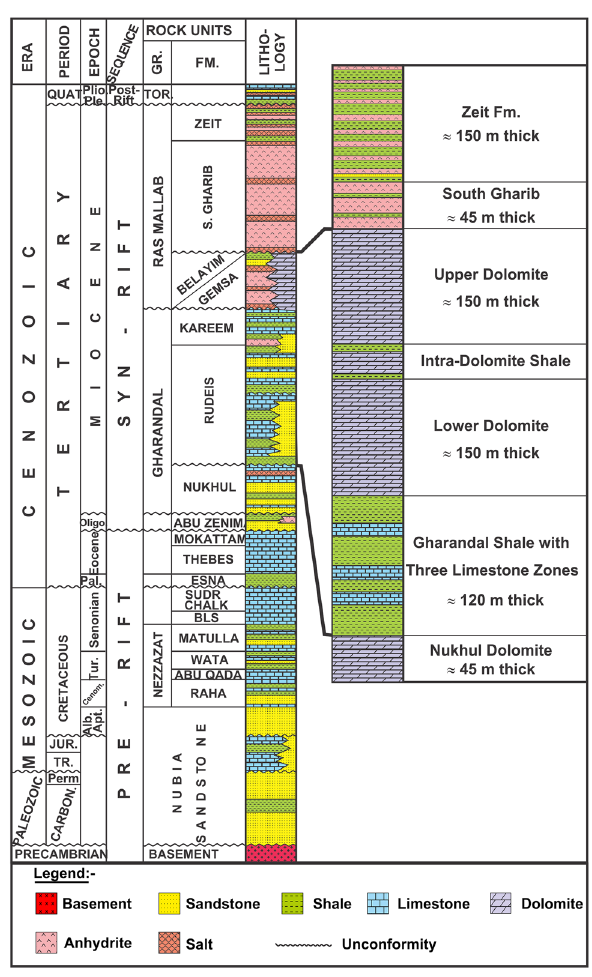
Fig. 2 A simplified stratigraphic section of the Gulf of the Suez. The detailed interval of the Miocene rocks represents the Miocene stratig- raphy of Issaran field, after Saoudi et al.